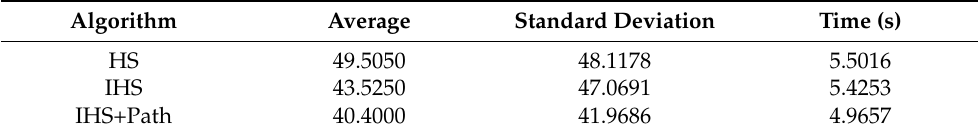
Table 2. Convergence analysis results for the 14-bus test